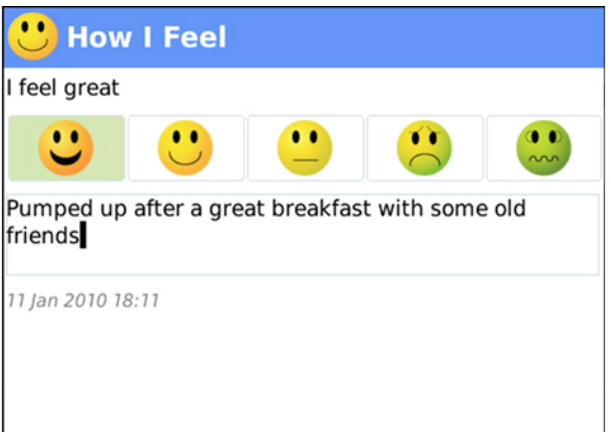
Figure 6. Mood Tracker: Clients enter “How They Feel” using a simple 5-pt scale: I feel (great, very good, good, bad, very bad) and comment on entry, which is